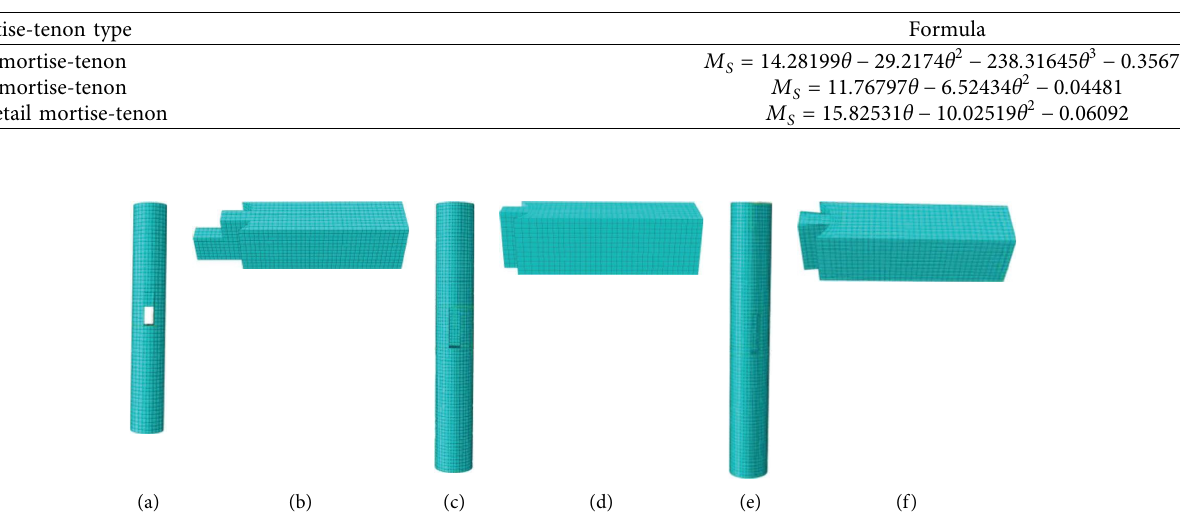
Figure 15: Load-bearing skeleton curves of fat steel strips on diferent mortise and tenon nodes. Table 9: Diferent nodes M s relationship model.